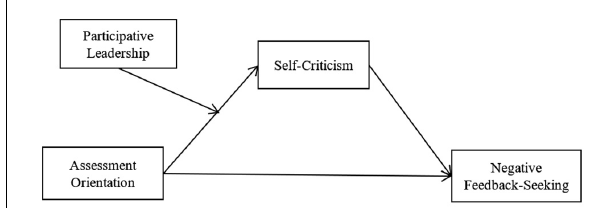
FIGURE 1 | Hypothesized